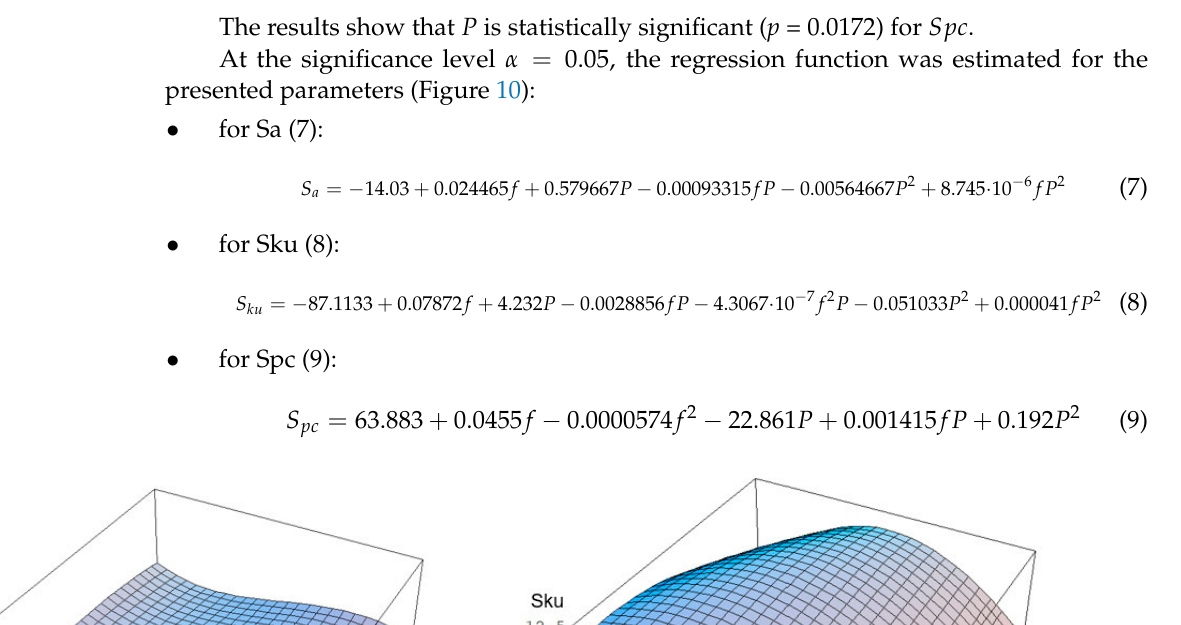
Table 8. The p -value for ANOVA test— Sa , Sku , and Spc parameters. S a S ku S pc P 0.0315 0.338 0.0172 f 0.4531 0.309 0.9168 The results show that P is statistically significant ( p = 0.0172) for Spc .